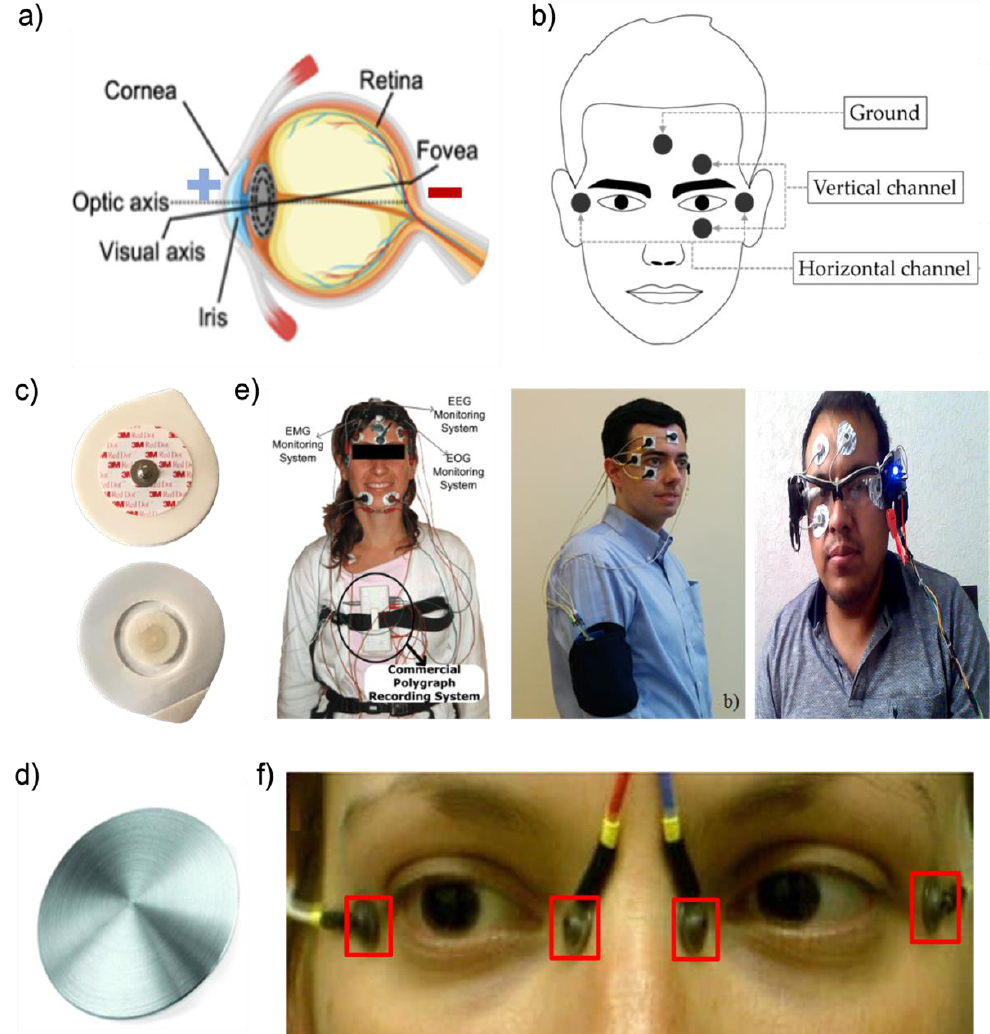
Figure 2. EOG detection systems. ( a ) An anatomical illustration of the eye (cornea being positive and retina being negative). ( b ) Positions of electrodes for EOG detection (reprinted under terms of the CC-BY license [51]. Copyright 2017, the authors. Published by MDPI). ( c ) Conventional Ag/AgCl electrodes. ( d ) Example of a stiff material (metal disc) (Reprinted with permission [86]. Copyright 2013 Institute of Physics and Engineering in Medicine). ( e ) Exiting EOG devices with conventional gel electrodes (Left: Reprinted with permission [81]. Copyright 2009 Elsevier, Middle: reprinted with permission [60]. Copyright 2018 Elsevier, Right: reprinted under terms of the CC-BY license [37]. Copyright 2021, the Authors. Published by MDPI). ( f ) Exiting EOG devices with dry metal electrodes (Reprinted under terms of the CC-BY-NC license [87]. Copyright 2018, the Authors. Published by Springer